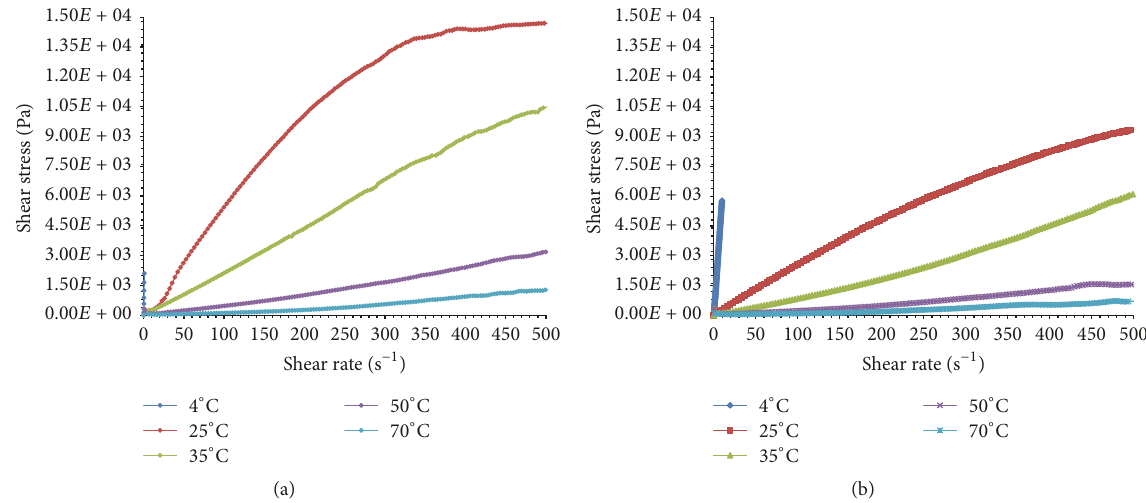
Figure 1: Flow curves of OsLu (a) and Vivinal GOS (b) at different temperatures: 4, 25, 35, 50, and 70 ∘ C.